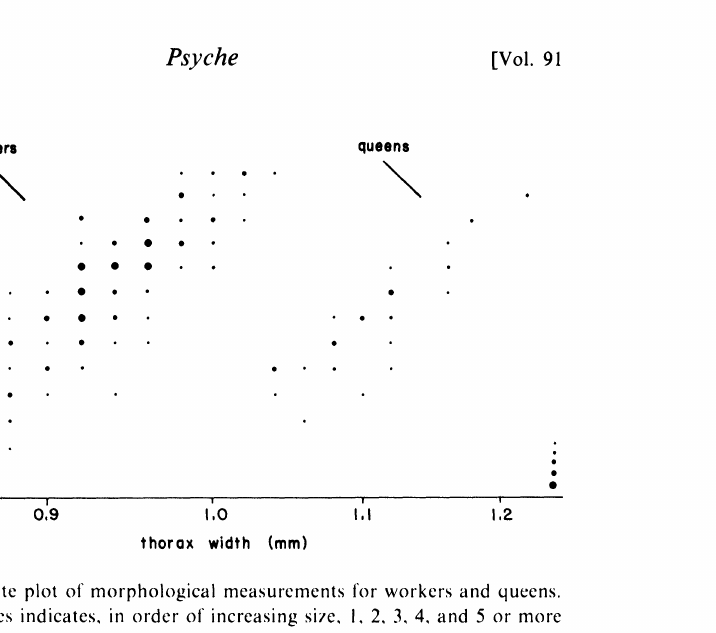
Fig. I. Bivariate plot of morphological measurcmcnts for workcrs and queens. Si/c of filled circlcs indicates, in order of increasing size. I. 2. 3.4. and 5 or more individuals. Workers: n=!36, slope=0.74, correlation=0.82. Queens: n=33. slope= 0.77. correlation=0.89. Data arc from two